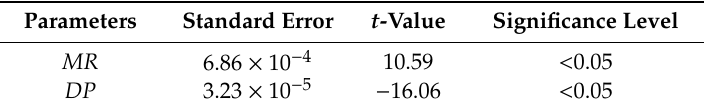
Figure 12. The fitting results of the model of furfural equilibrium distribution. Table 5. The goodness of fit of furfural equilibrium distribution model. Table 5. The goodness of fit of furfural equilibrium distribution model.